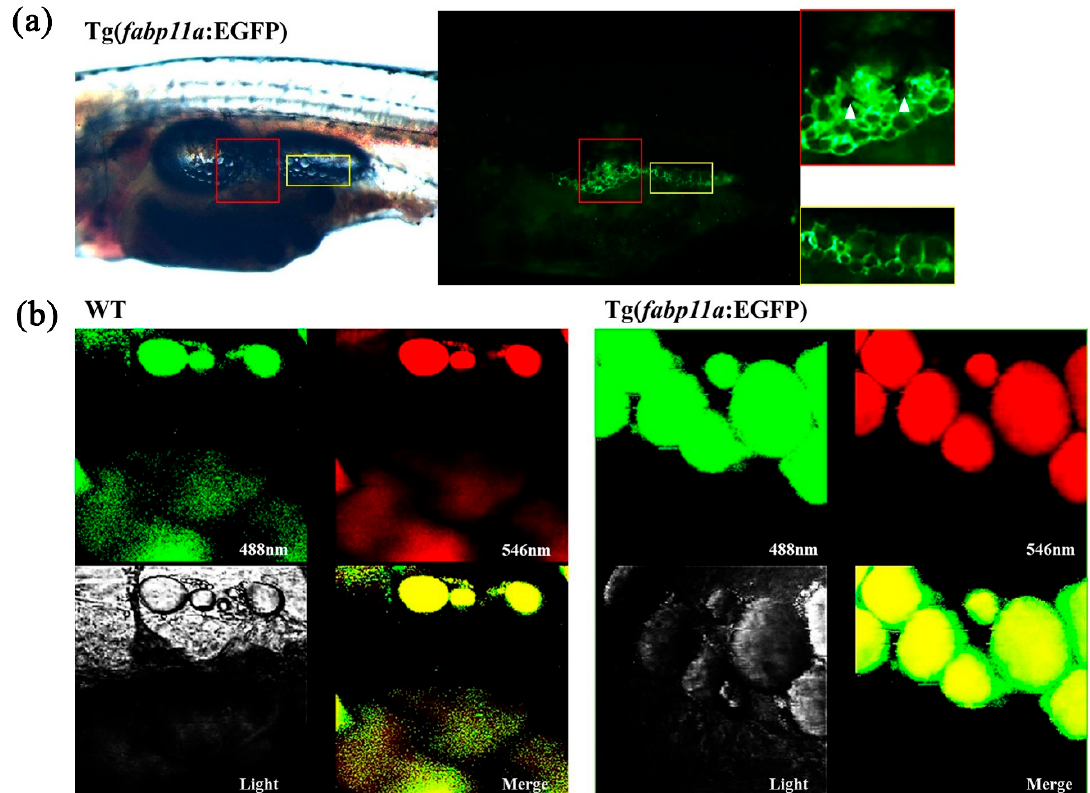
Figure 2. Visualization of adipocyte morphology in the transgenic zebrafish. ( a ) Images of trunk regions of zebrafish at 18 dpf and zoom-in views of the boxed areas. Red colored boxes show an area of pancreatic adipose tissue with multilayered adipocytes. Yellow colored boxes show an area of adipose tissue with single layer of adipocytes. White arrowheads indicate pigment cells. ( b ) Confocal images of adipocytes after Nile Red staining which is shown in both green and red. Green fluorescent signals are from both EGFP in the cytoplasm and Nile Red-stained lipid droplet, whereas red fluorescent signal is only from lipid droplet. Merged images show yellow lipid droplet and green cytoplasm.